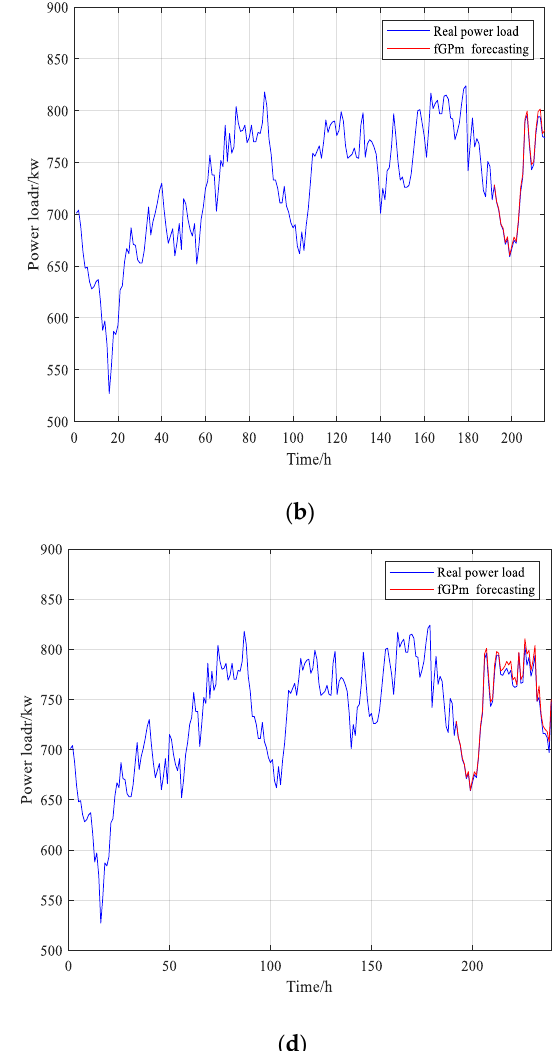
( d ) Figure 13. Comparison of two forecasting models in working days. ( a ) 6 h ( b ) 12 h ( c ) 18 h ( d ) 24 h. Table 3. The workday forecasting relative error (%) of power loads on adjacent dates. Forecast Time